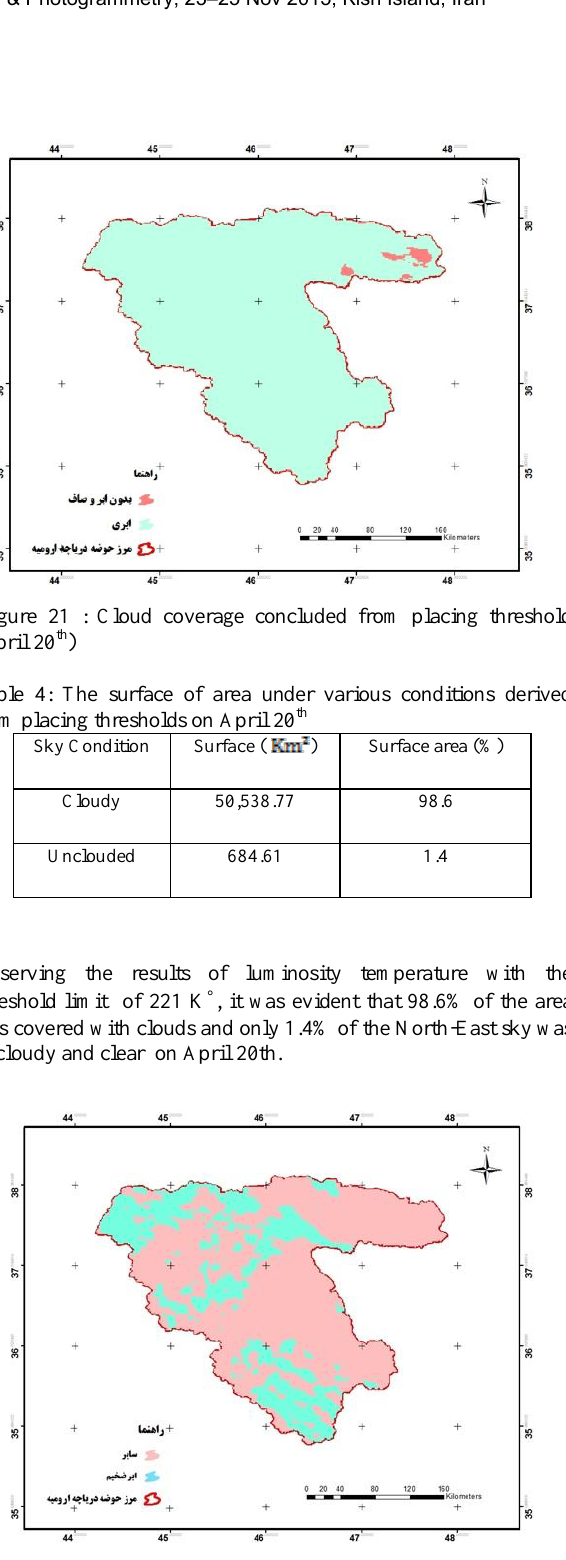
Figure 22: Thick clouds concluded from threshold placing of the first group models (April 20 th